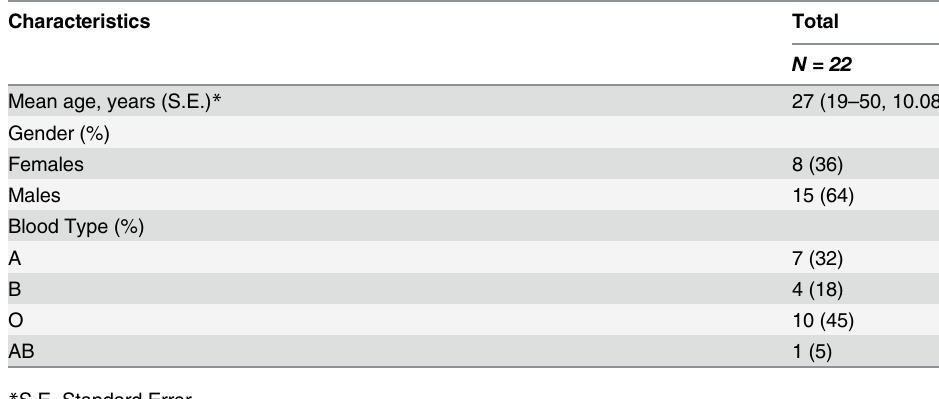
Table 1. Demographic characteristics of study